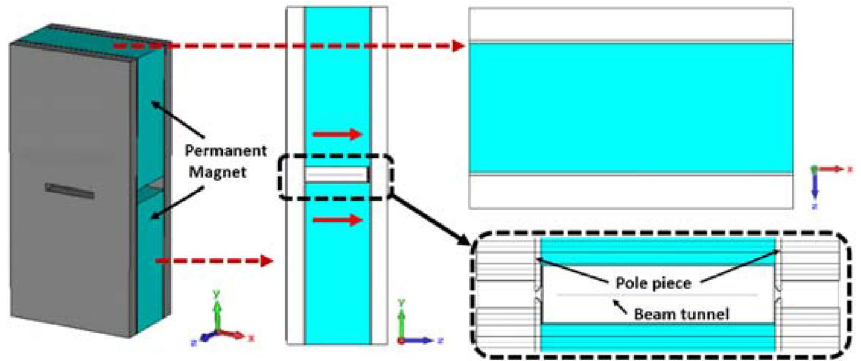
Figure 12. Structure of the uniform magnetic focusing field system.